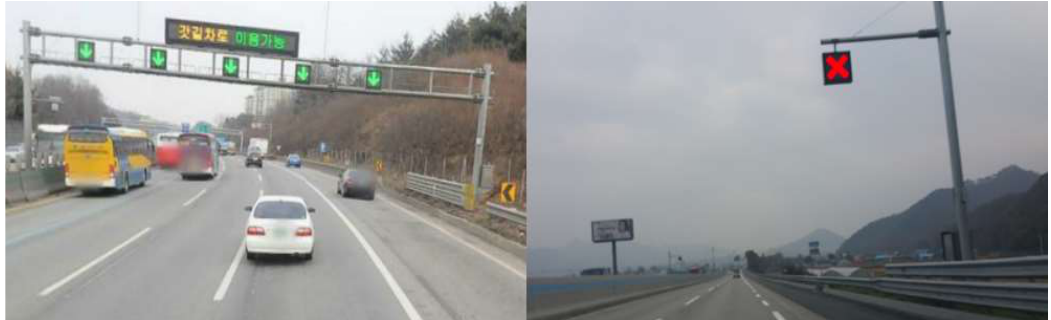
Figure 2. Hard shoulder running in South Korea.